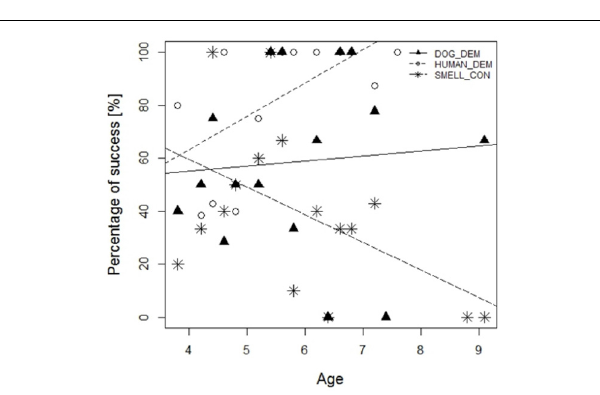
FIGURE 3 | Box plots showing the successful wolves and dogs’ latency to find the chick in the 3 conditions. Boxes represent the interquartile range, bars within shaded boxes are median values, whiskers indicate the 5th and 95th percentiles, and open circles are